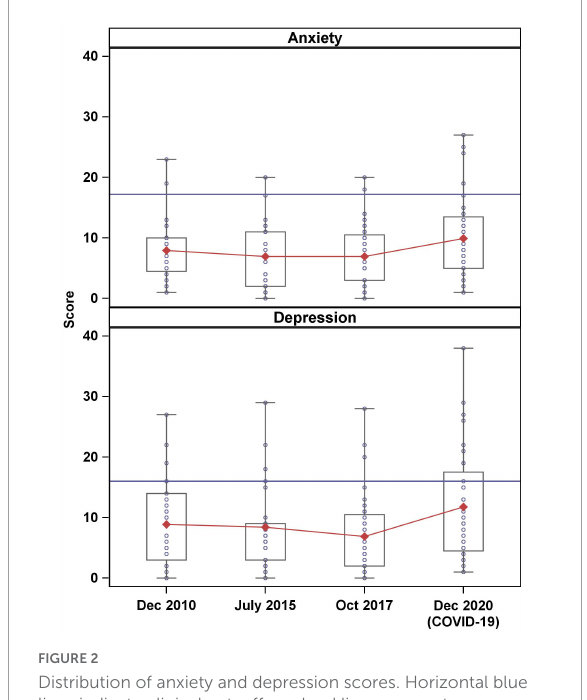
slightly positive, noting improvements in exercise ( n = 5), eating ( n = 6), and sleeping ( n = 7). None of them reported clinically significant levels of depression or anxiety, nor did they face increased economic anxiety due to COVID-19. None